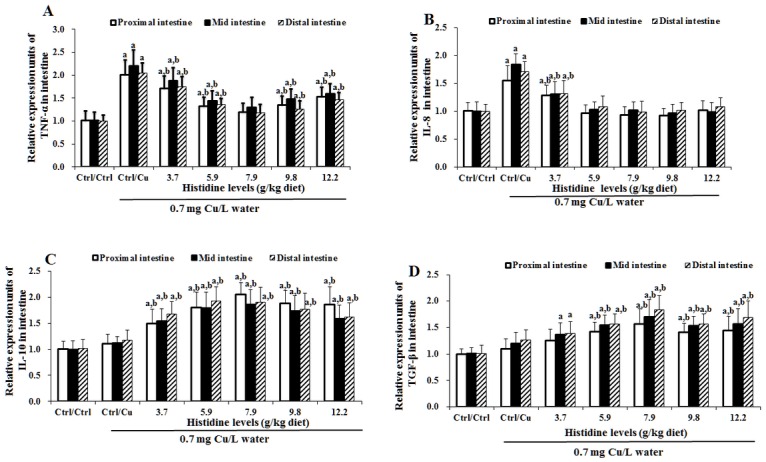
Cu induces increases in cytokine mRNA levels in carps. The (A) TNF-α, (B) IL-8, (C) IL-10, and (D) TGF-β mRNA levels in proximal intestine, mid intestine and distal intestine of young grass carp.The protocol and indications are shown in Fig 3. TNF-α, Tumour necrosis factor α; IL-8, interleukin 8; IL-10, interleukin 10; TGF-β, transforming growth factor β.